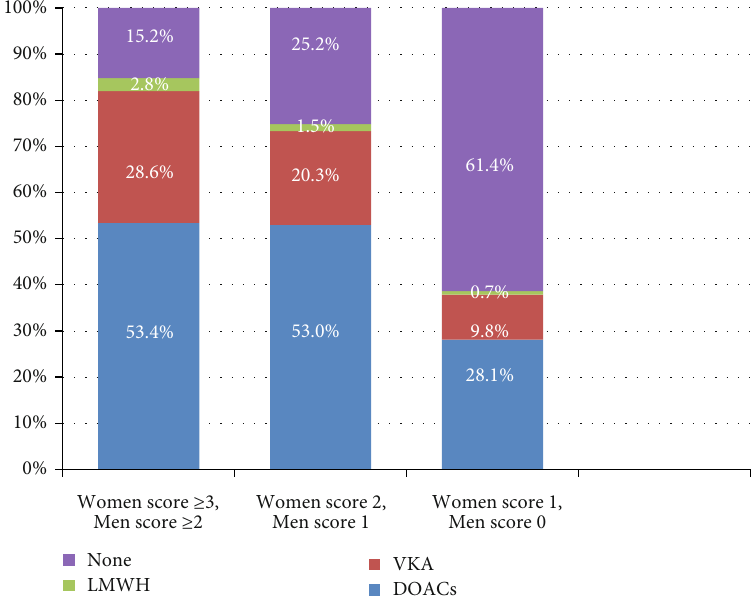
Figure 1: Use of anticoagulant agents in patients with nonvalvular AF according to the CHA anticoagulant agents; LMWH: low molecular weight heparin; VKA: vitamin K antagonist.